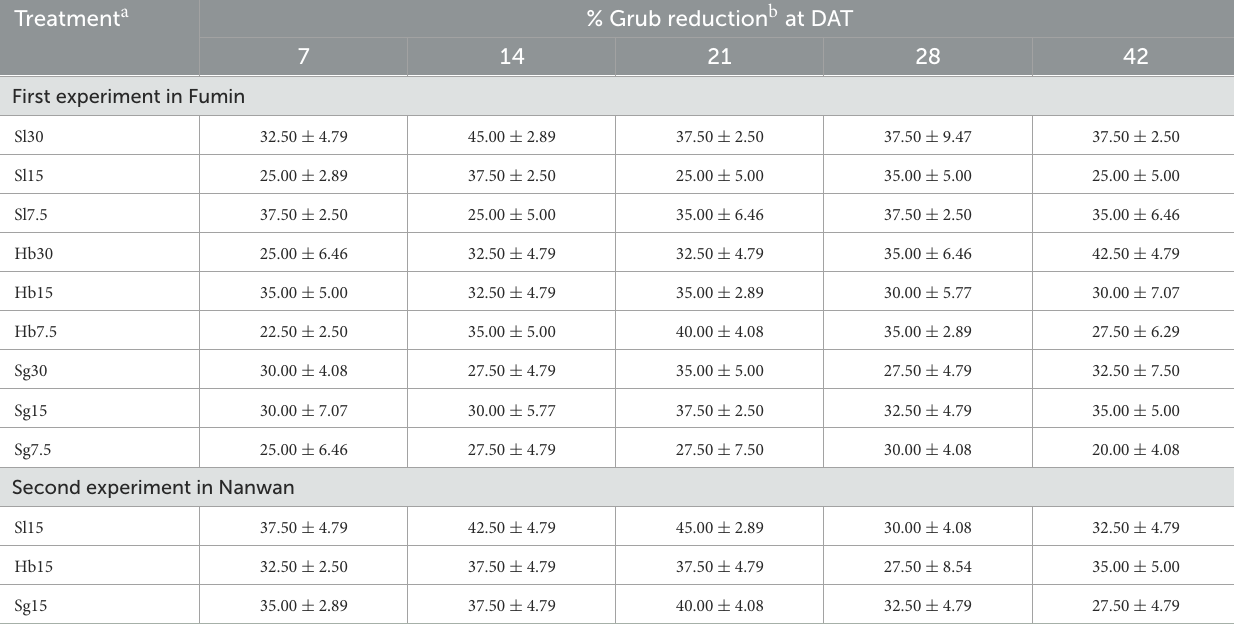
TABLE 2 Corrected mortality of Tenebrio molitor bait larvae in soil samples collected from the first (Fumin) and second (Nanwan) experiments conducted in Shandong, China at 7, 14, 21, 28, and 42 DAT. Treatment